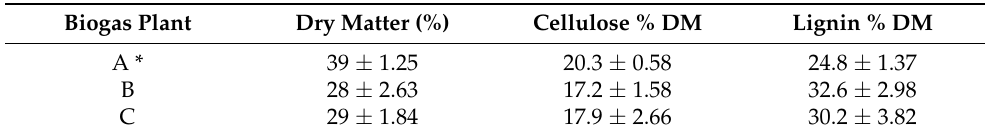
Table 2. Results of analyses of solid fraction of biogas digestate A, B, C. Basic component of ma- terial processed in biogas plant: plant A—corn silage; B, C—corn silage, cattle and pig manure, poultry manure. The content of components was determined for p